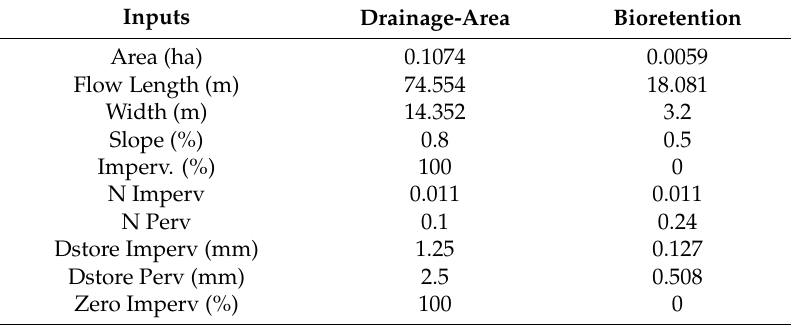
Table 1. Input parameters for the drainage area.